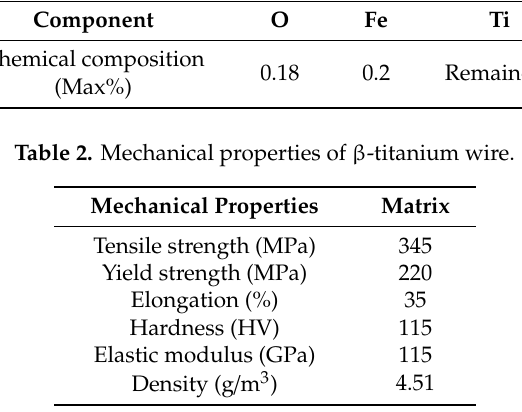
Table 1. Chemical composition of β -titanium wire.